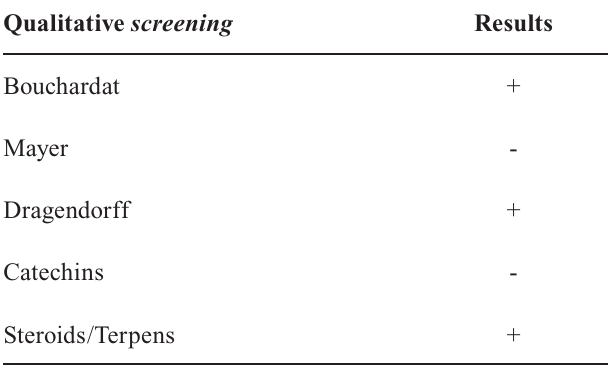
TABLE II - Qualitative screening and content metabolites present in the CEE from T.